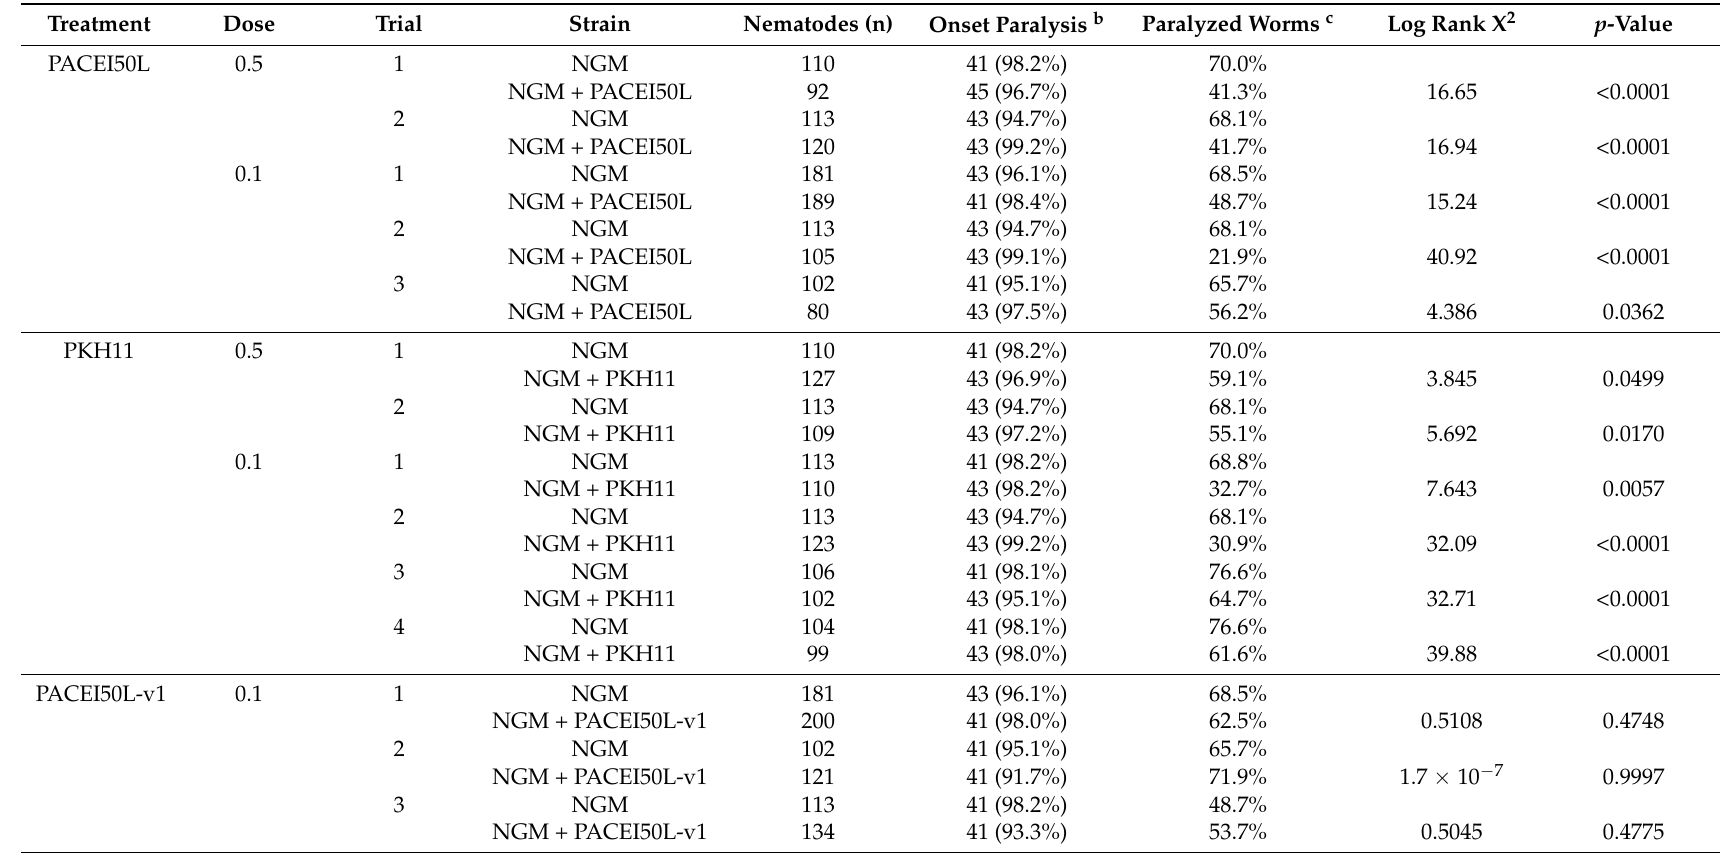
Table 4. Effects of peptide treatments on the CL4176 paralysis and statistical analyses of the paralysis curves a